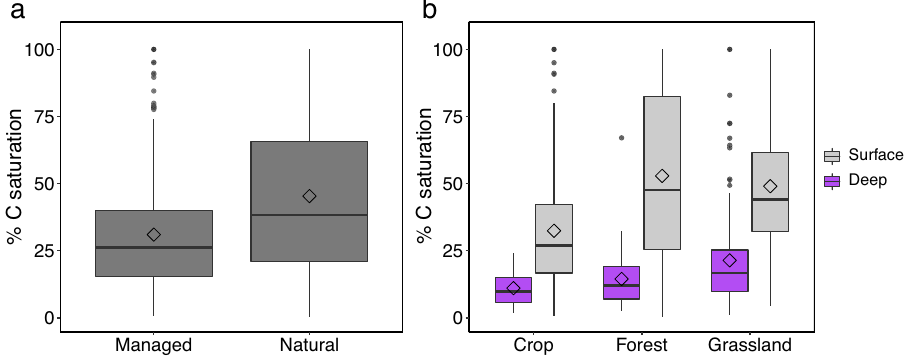
Fig. 2 Percent mineralogical carbon saturation across ecosystems and soil depths. Percent mineralogical C saturation (%C saturation) — i.e., the proximity of a soil to its mineralogical carbon capacity (MOC max ) — was calculated for each measurement in our observational synthesis. a %C saturation grouped by managed ( n = 573) and natural ( n = 862) ecosystems across depths (see “ Methods ” ). b %C saturation by ecosystem (cropland, forest, and grassland) and depth (surface < 30 cm and deep > 30 cm). Only categories with >5 observations for both surface (cropland n = 425; forest n = 242; grassland n = 355) and deep (cropland n = 21; forest n = 53; grassland n = 136) soils are shown. Box plots indicate the medians (horizontal lines), 1st and 3rd quartiles (boxes), 1.5× interquartile range (whiskers), and means (diamonds).